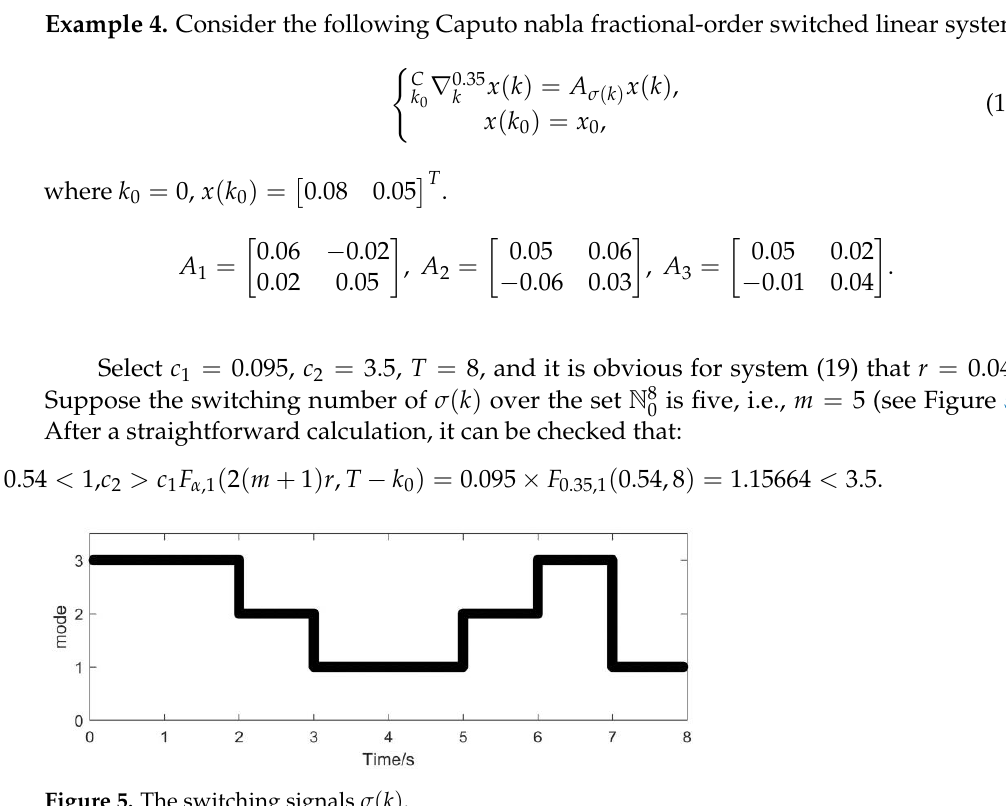
Figure 5. The switching signals  ( ) k .